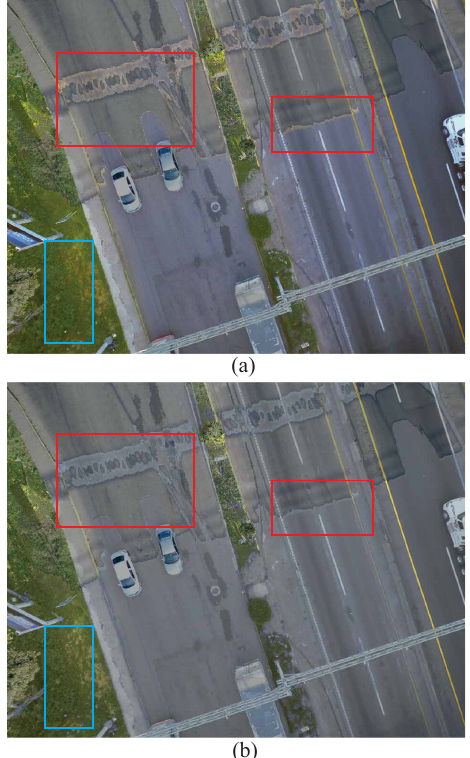
Figure 4. Color transfer result ( a ); color tuning result ( b ). Red rectangles focus on concrete areas and blue in vegetation or